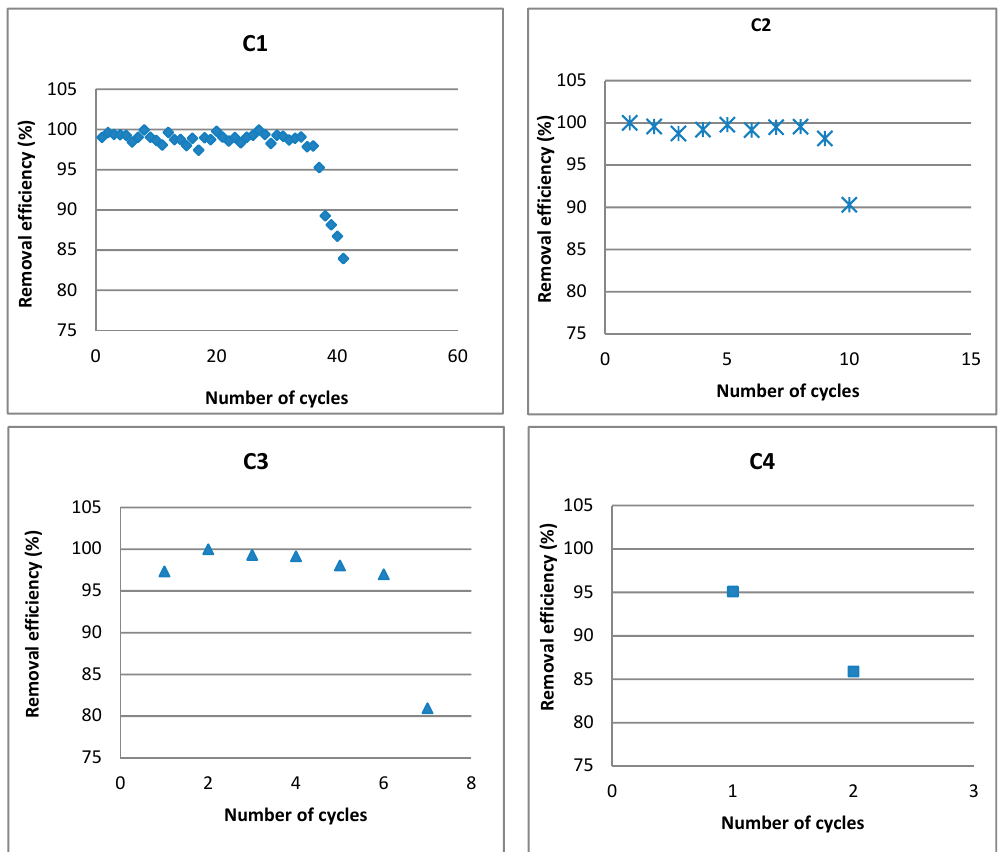
Figure 6. Removal efficiency as a function of number of cycles.